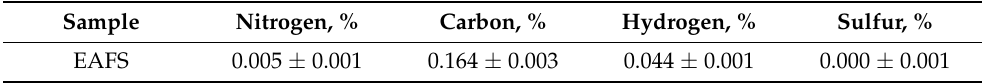
Table 7. Elemental analysis of the electric arc furnace